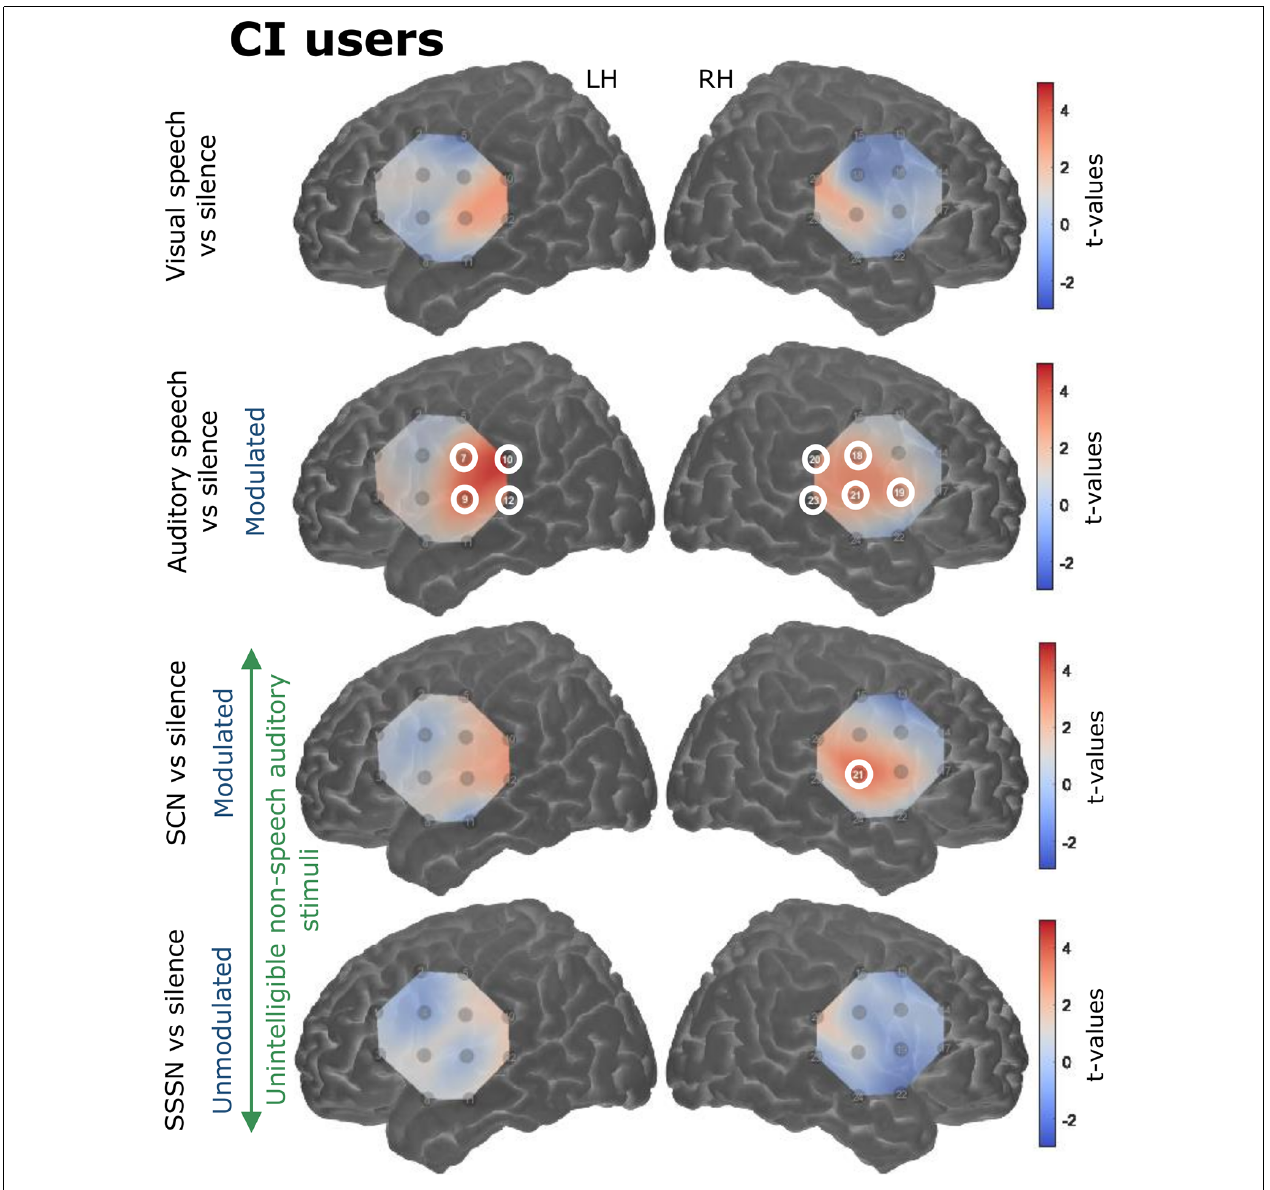
FIGURE 7 | Group level cortical activation maps for each stimulation condition contrasted against silence in CI users in the LH and the RH. Channels circled in white show statistically significant activation ( q < 0.05, FDR corrected). Channels targeting temporal regions in both hemispheres in response to auditory speech were significantly activated. Significant activation was also observed in right-sided temporal regions in response to signal-correlated noise (SCN). Note that the maps are interpolated from single-channel results and the overlay on the cortical surface is for illustrative purposes